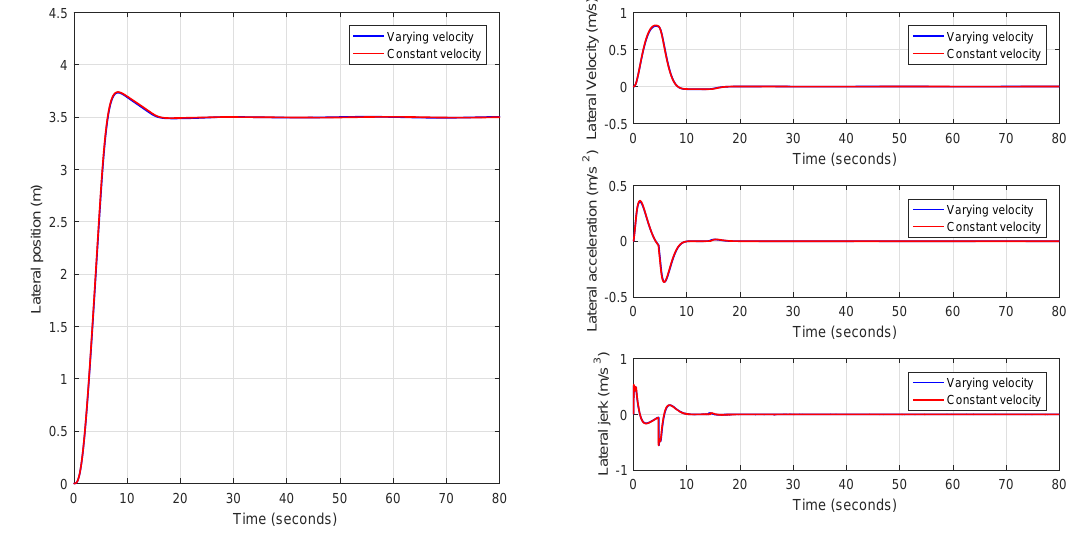
Figure 31. Validation of the controller with variable band and optimal reset for varying longitudinal velocity (88.2–109.8 km/h) in CarSim.